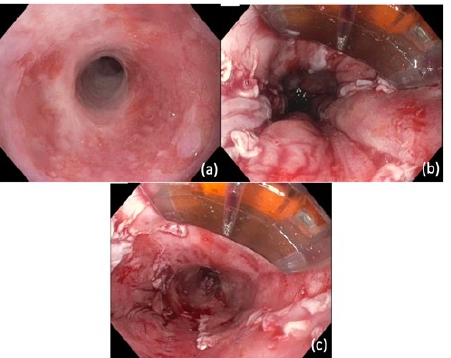
Figure 3. Radiofrequency ablation (RFA). ( a ) Evidence of Barrett’s esophagus and stenosis associ- ated with prior endoscopic mucosal resection ( b ) RFA performed using Barrx TM Halo Ultra Long Catheter ( c ) Segment of Barrett’s esophagus after RFA.